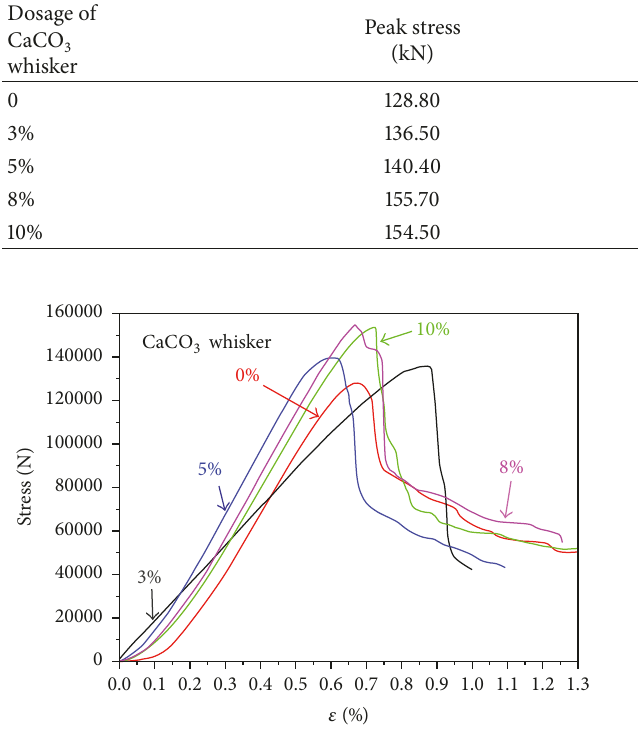
Figure 5: The stress-strain curve of different CaCO 3 whisker dosage cement pastes.